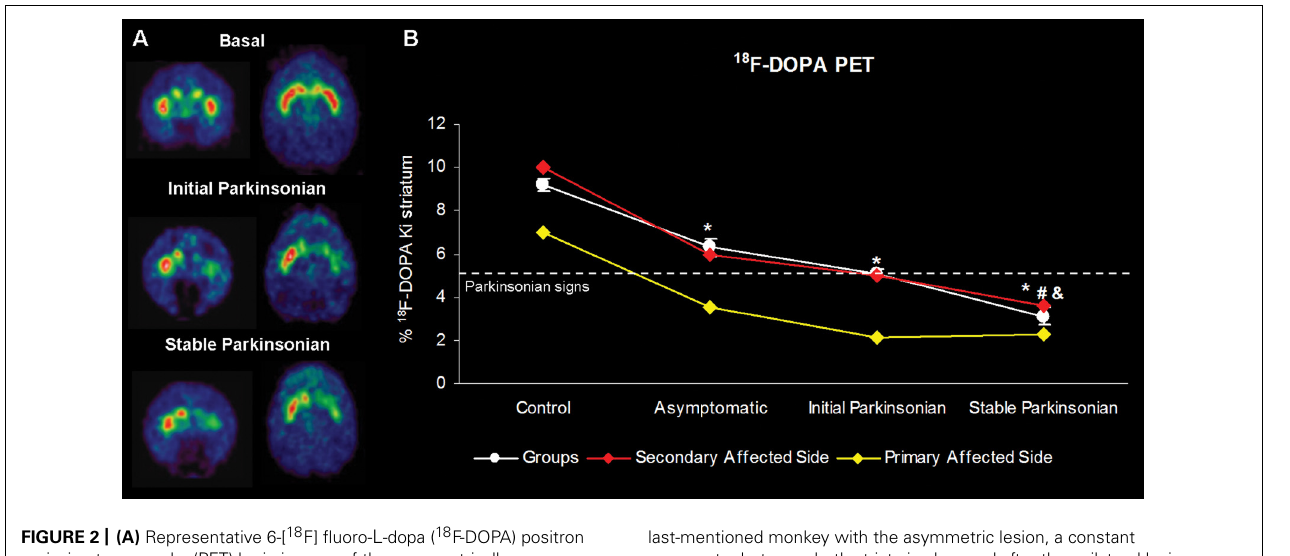
FIGURE 2 | (A) Representative 6-[ 18 F] fluoro- L -dopa ( 18 F-DOPA) positron emission tomography (PET) brain images of the asymmetrically affected (case-study) monkey in coronal and transversal orientation at baseline, after 1-methyl-4-phenyl-1,2,3,6-tetrahydropyridine (MPTP) treatment ( ∼ Initial Parkinsonian ), and after the final MPTP administration ( ∼ Stable Parkinsonian ). (B) Comparison of 18 F-DOPA uptake in control and MPTP-treated monkeys ( n = 16; white line), and dopaminergic uptake of the Primary Affected Side (yellow line) and Secondary Affected Side (red line) in the case-study monkey with asymmetric dopamine depletion. In